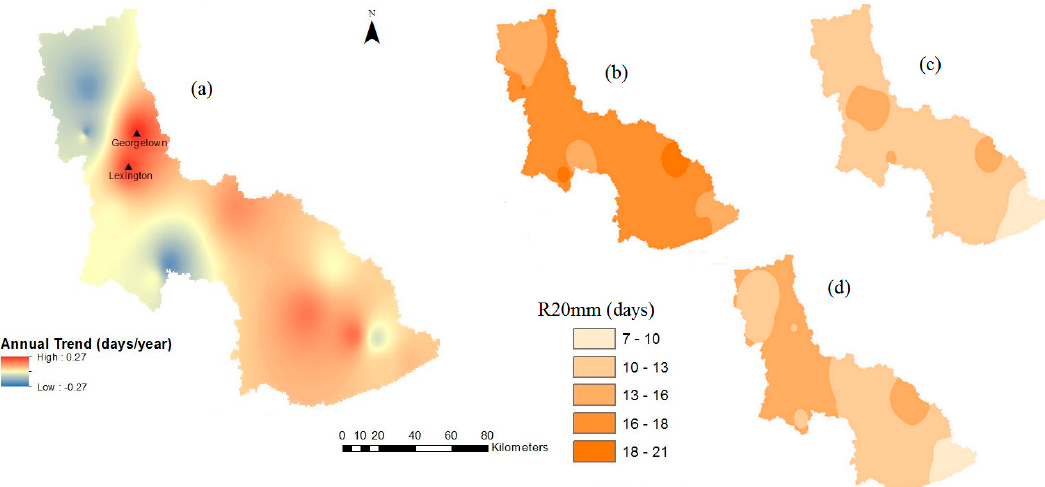
Figure 8. Spatial distribution of R20mm ( a ) trend and mean values under: ( b ) baseline; ( c ) late-century RCP 4.5; and ( d ) late ‐ century RCP 8.5, in the Kentucky River Basin. Filled triangles indicate a statistically significant ( p < 0.05) trend.